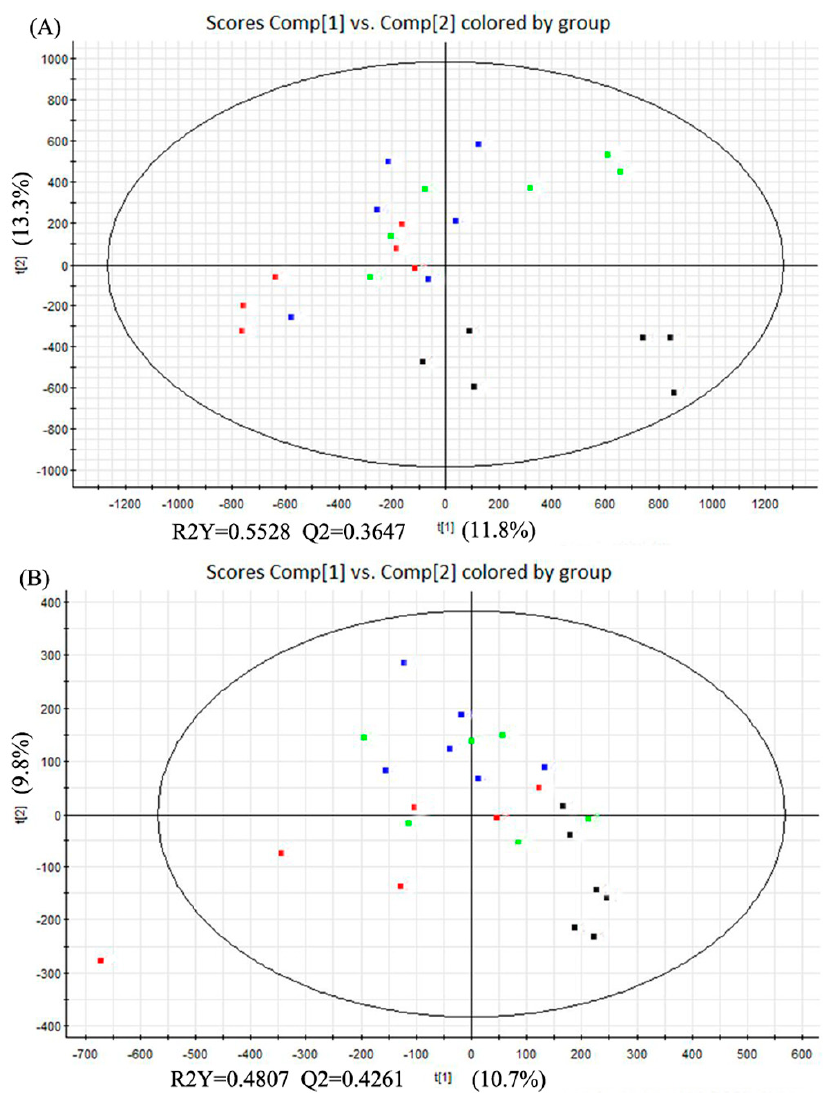
Figure 4. PLS-DA score plots of the four tested groups from UPLC-Q-TOF-MS profiling data. ( A ) PLS-DA score plot from positive ion mode; ( B ) PLS-DA score plot from negative ion mode. PLS-DA, Partial least squares discriminant analysis; UPLC-Q-TOF-MS, Ultra-performance liquid chromatography- quadrupole-time-of-flight-mass spectrometry. ( : Dextrose control; : Alcohol control; : 0.04%NTs; : 0.16%NTs).